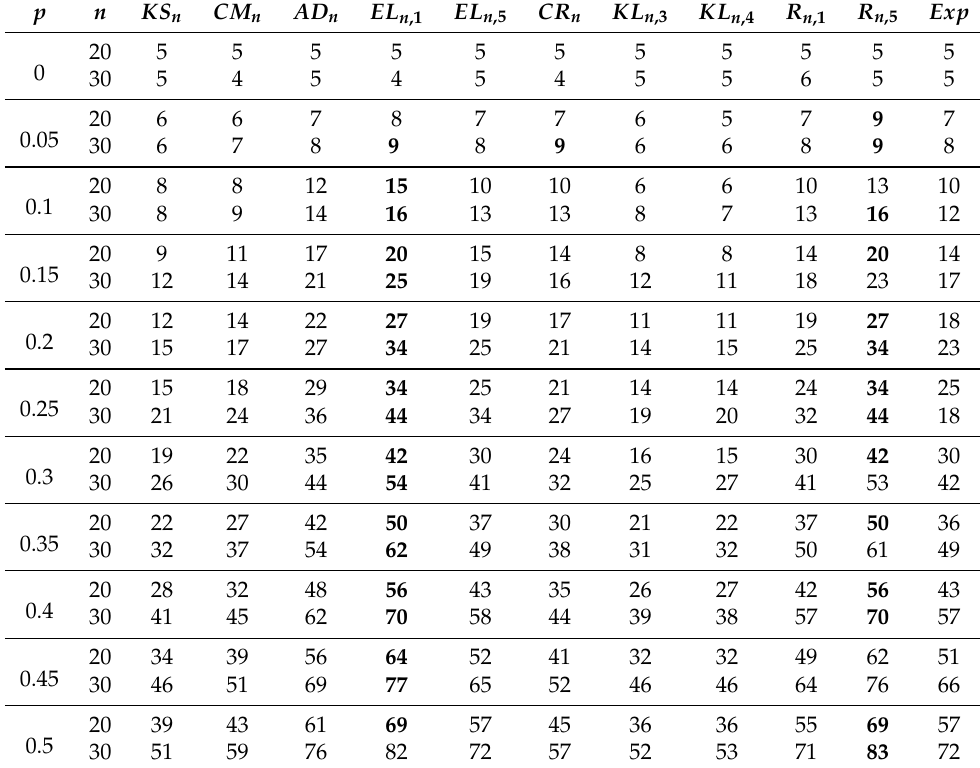
Table 2. Estimated local powers for the mixture of the Rayleigh and exponential distributions for various choices of the mixture parameter, p .